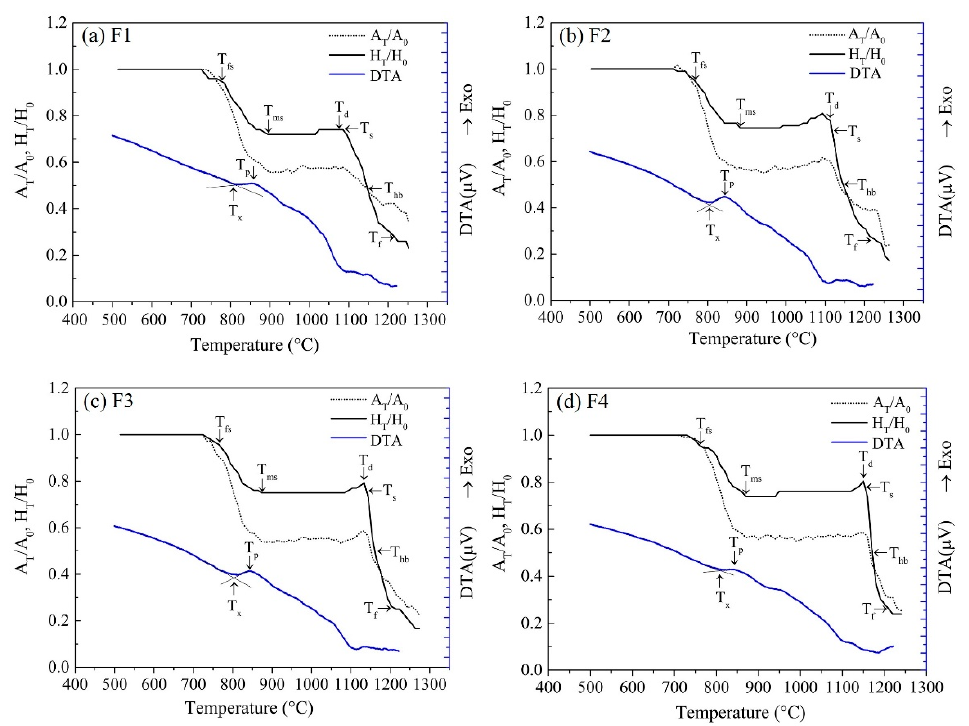
Figure 7. Shrinkage and DTA curves of samples F1–F4 (Note: T x —onset temperature of crystalliza- tion; T p —crystallization peak temperature; T fs —onset temperature of sintering; T ms —temperature of maximum shrinkage before softening; T d —onset temperature of softening; T s —softening temperature; T hb —hemispheric temperature; T f —flowing temperature; A T , H T are the area and height of sample images at temperature T, respectively). ( a ) sample F1; ( b ) sample F2; ( c ) sample F3; ( d ) sample F4. Table 4. Characteristic temperatures for samples F1–F4.